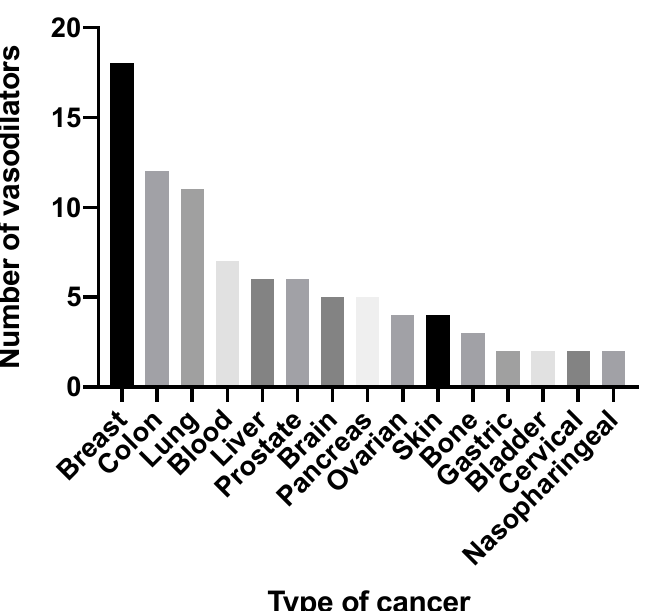
Figure 2. Summary of data evidence of anticancer activity of vasodilator drugs by cancer type, as reported in this review.